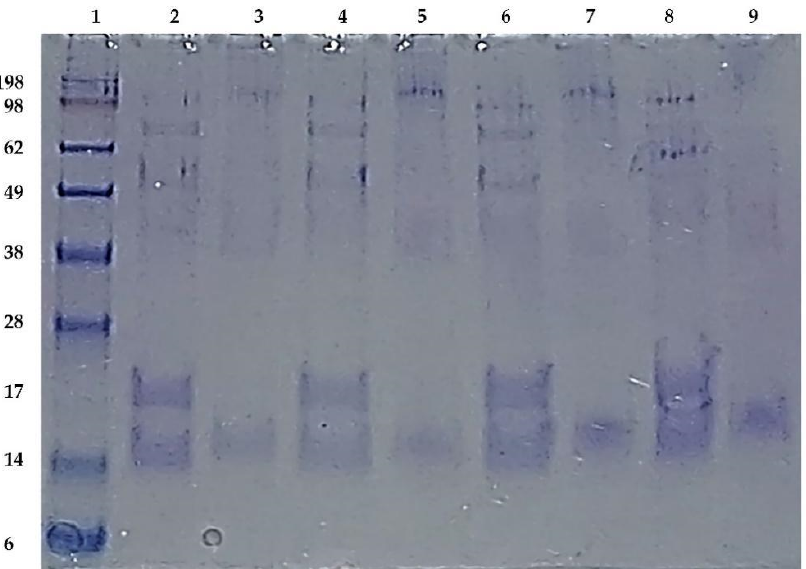
Figure 5. SDS-PAGE electrophoresis of MAP3773c showing the oligomerization of MAP3773c under different conditions. Lane 1, molecular weight marker; Lane 2, MAP3773c with β -mercaptoethanol; Lane 3, MAP3773c without β -mercaptoethanol; Lane 4, MAP3773c with 10 mM DTT and β -mercaptoethanol; Lane 5, MAP3773c with DTT and without β -mercaptoethanol; Lane 6, MAP3773c with 15 mM Mn 2+ with β -mercaptoethanol; Lane 7, MAP3773c with 15 mM Mn 2+ without β -mercaptoethanol; Lane 8, MAP3773c with 15 mM Zn 2+ with β -mercaptoethanol; Lane 9, MAP3773c with 15 mM Zn 2+ without β mercaptoethanol.